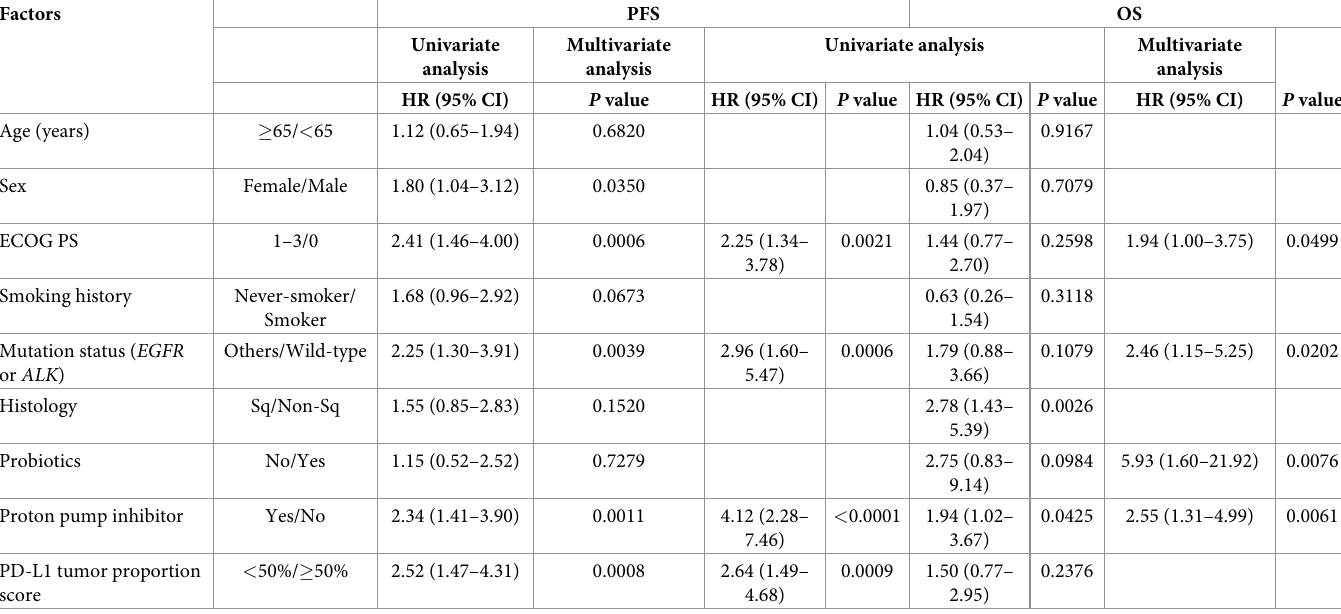
Table 3. Inverse probability of treatment weighting-adjusted univariate and multivariate analyses of PFS and OS. Factors